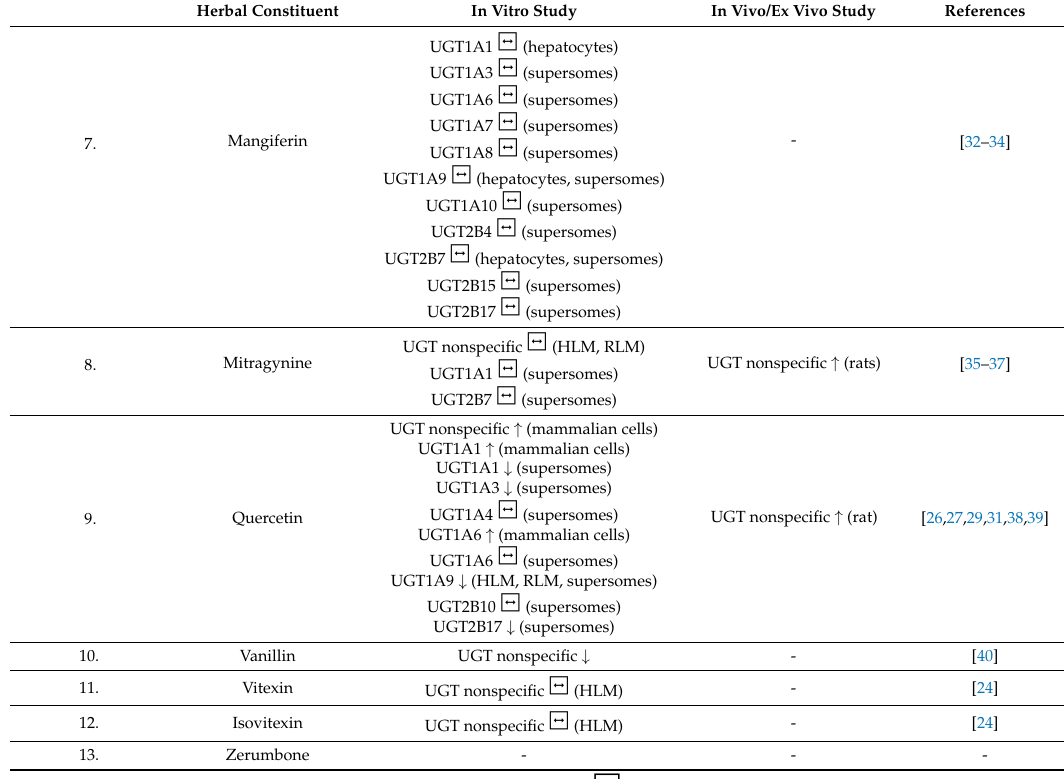
Table 1. The effect of selected herbal constituents on UDP-glucuronosyltransferase (UGT) isoforms activities.